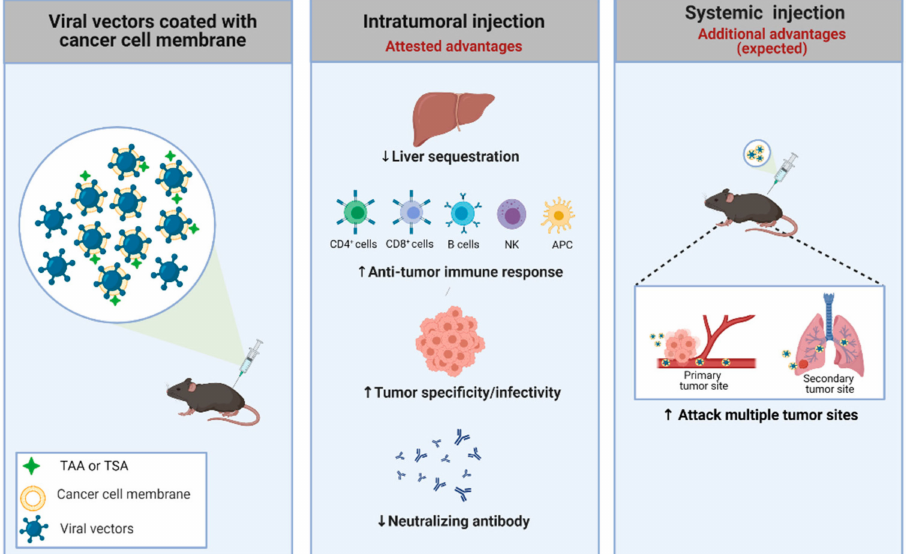
Figure 2. Strategy used to improve the specificity of adenoviral vectors. An adenovirus coated with a cancer cell membrane has some advantages, such as the presence of TSA and TAA, which aids the anti-tumor immune response. Additionally, the membrane can be engineered to present specific molecules/receptors, improving the power of interaction with the tumor. Moreover, the viral coating can offer several benefits, including suppression of liver toxicity, increase of specific infectivity to cancer cells, preferential antitumor (not antiviral) immune response, and escape from pre-existing neutralizing antibodies in both routes of delivery (intratumoral and systemic). Systemic administra- tion using virus coated with membranes could offer a highly desirable outcome: targeting metastatic foci. TAA: tumor-associated antigens; TSA: tumor-specific antigens. Created with